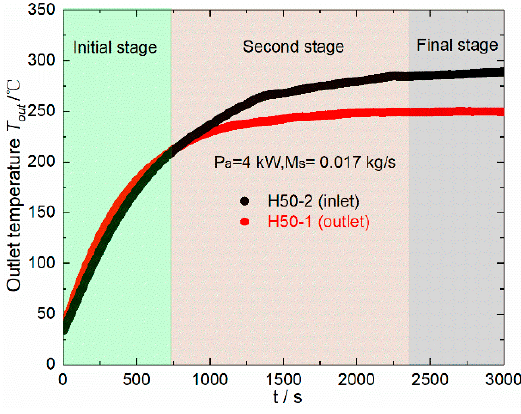
Figure 7. Outlet temperature response curve of H50.